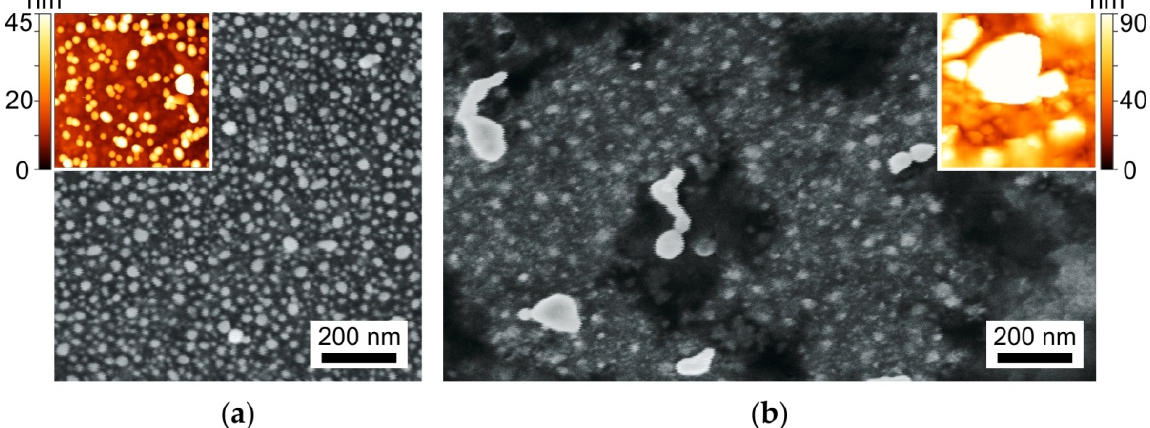
Figure 1. SEM and AFM images of silver nanoislands formed on the glass surface via out-diffusion before ( a ) and after 1 day exposure to PBS ( b ).